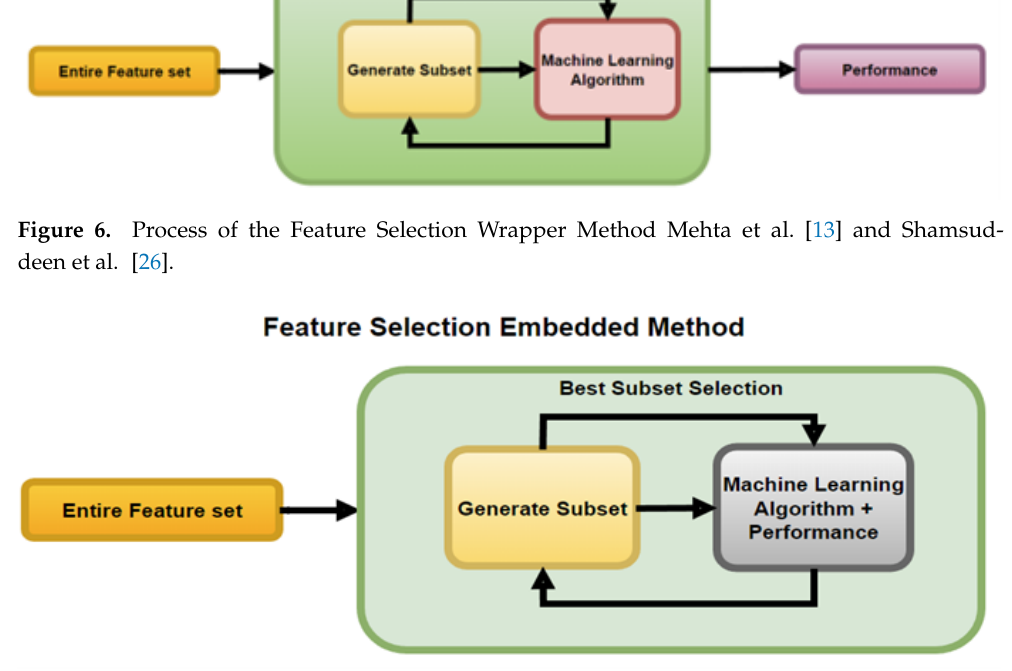
Figure 7. Process of the Feature Selection Embedded Method Shamsuddeen et al.